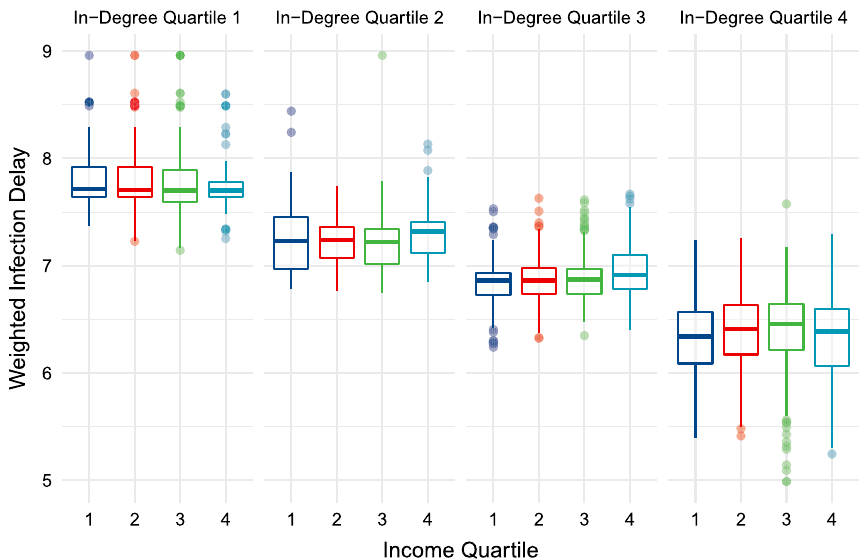
Fig. 9 Weighted median infection delay values across income quartiles, while controlling for in-degree